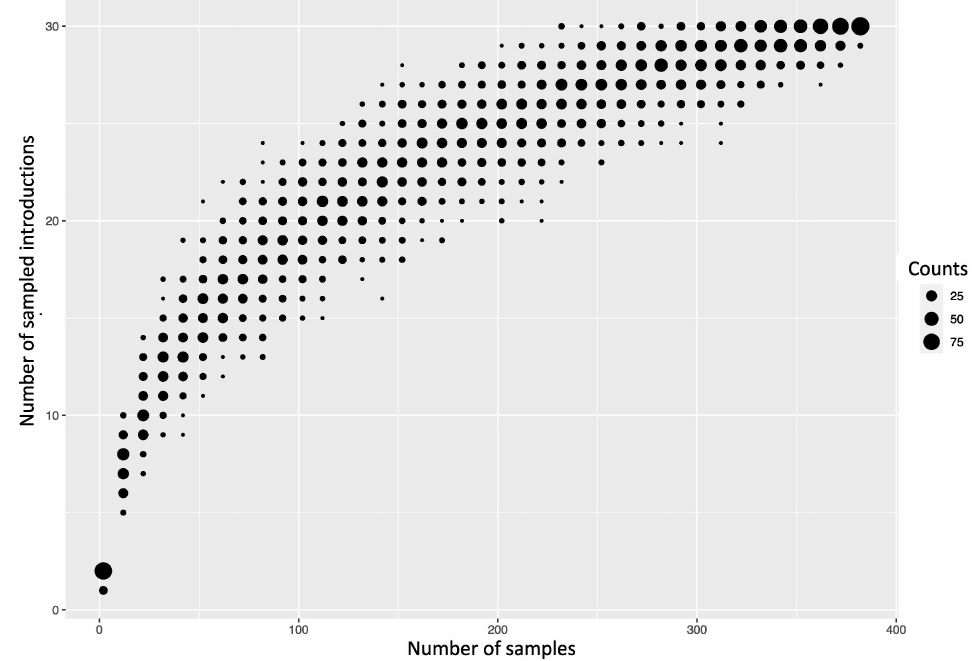
Figure 4. Number of introductions of A(H1N1)pdm09 viruses into Kenya depending on how many random sequences from Kenya were used to infer